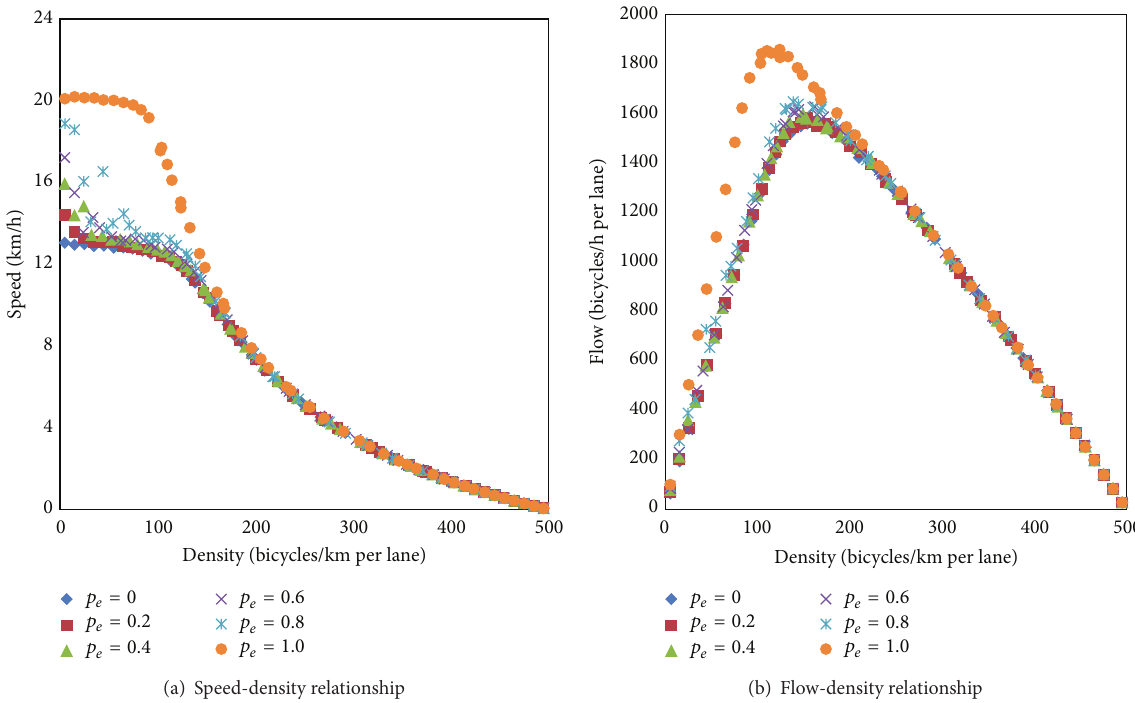
Figure 3: Speed-density and flow-density relationships under different proportions of EBs when 𝑝 𝑑 = 0.2 and 𝑝 𝑡 = 0.8.